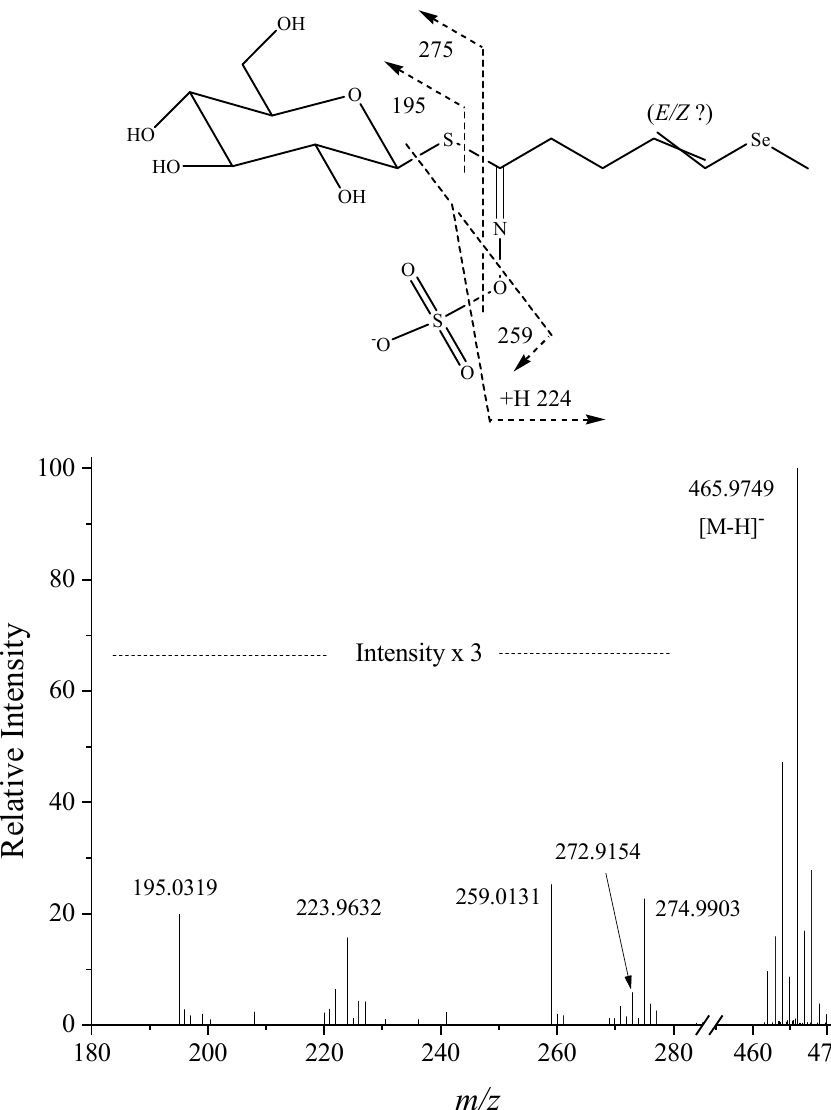
Figure 3. Fragmentation of the pseudomolecular ion ([M-H] − , m / z 466) of 4MSeB3 tentatively identified in an ethanol extract of Raphanus sativus sprouts fertilised with selenium. Ionisation energy was 26 eV and the collision cell gas was nitrogen. The daughter ions are shown at three-fold higher intensities, relative to the parent ion, than observed.